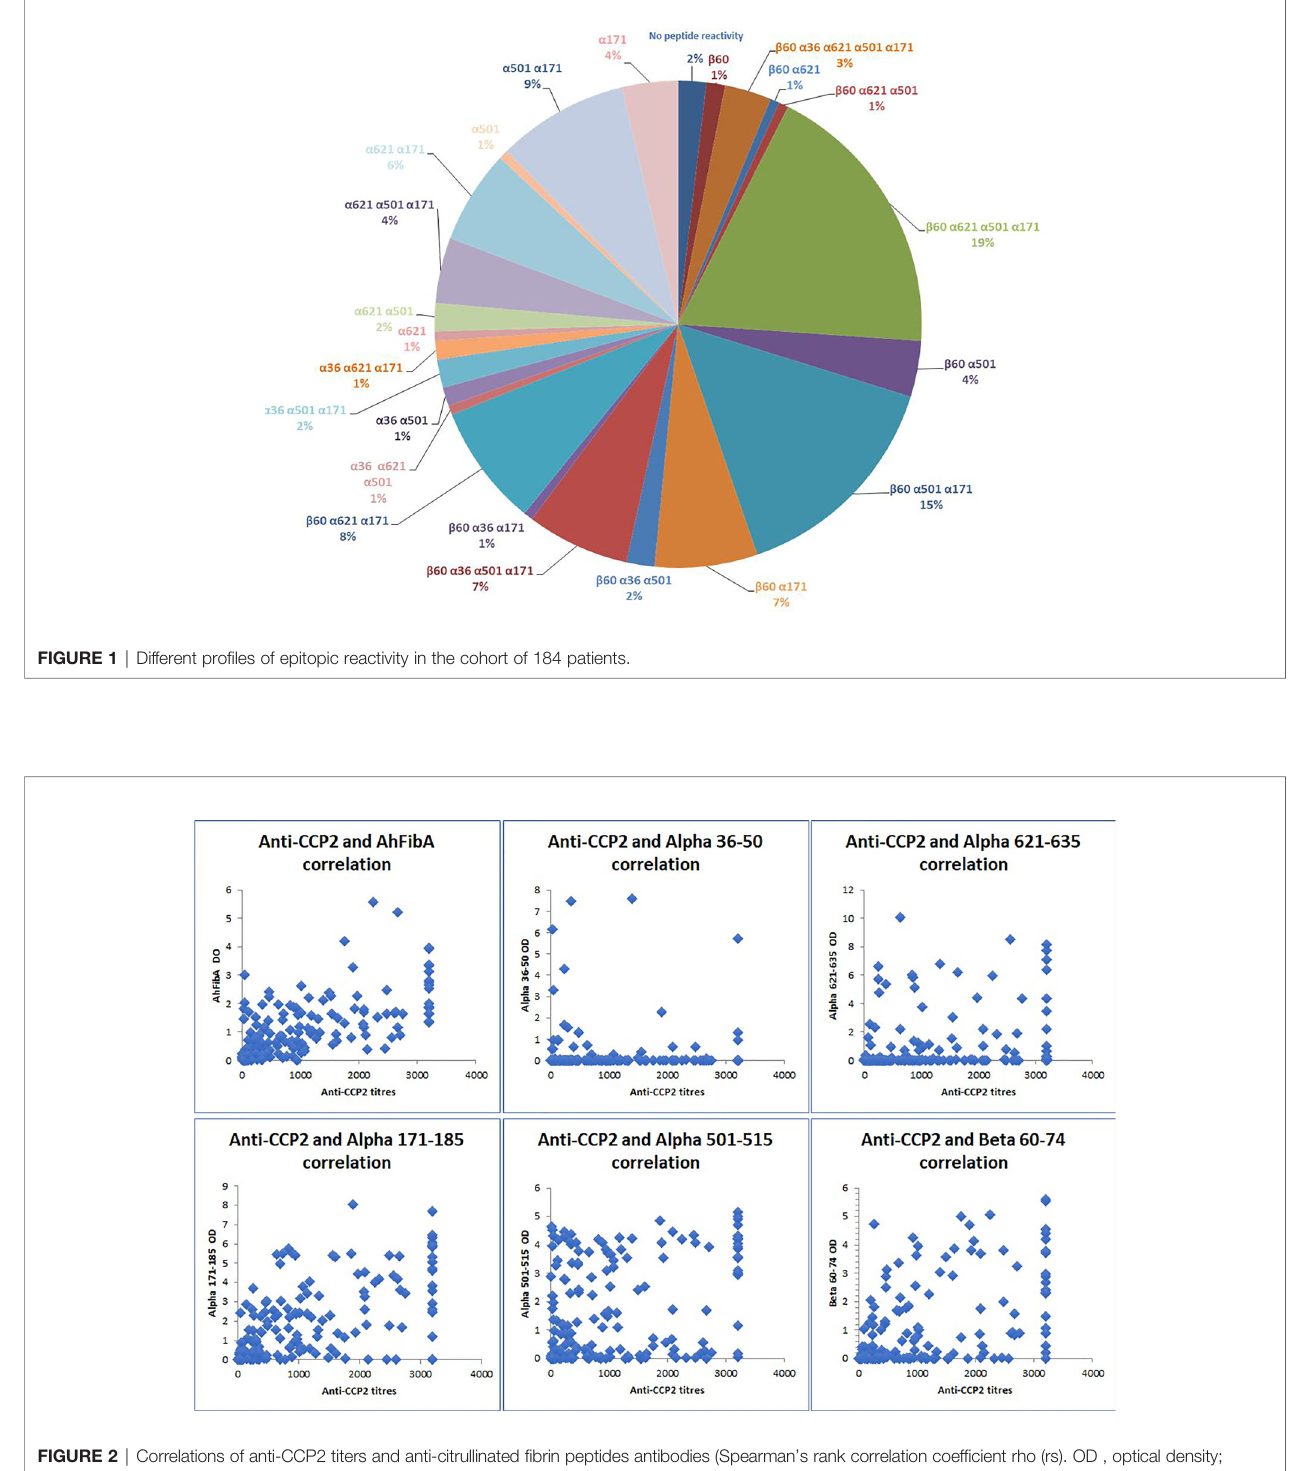
FIGURE 2 | Correlations of anti-CCP2 titers and anti-citrullinated fi brin peptides antibodies (Spearman ’ s rank correlation coef fi cient rho (rs). OD , optical density; AhFibA , anti-citrullinated human fi brinogen antibodies; anti-CCP2, anti-cyclic citrullinated peptides. There was a positive correlation between anti-CCP2 and AhFibA (r s : 0.706; p = 4.06x10 -29 ), between anti-CCP2 and anti- a 171-185cit (rs: 0.647; p = 3.2x10 -23 ), anti- a 501-515cit (rs: 0.299; p = 3.7x10 -5 ),anti- a 621-635cit (rs: 0.271; p= 0.0002), and anti- b 60-74cit antibodies (rs: 0.517; p = 5.5x10 -14 ). There was no correlation between anti-CCP2 and anti a 36 – 50 (rs: -0.010; p = 0.894)